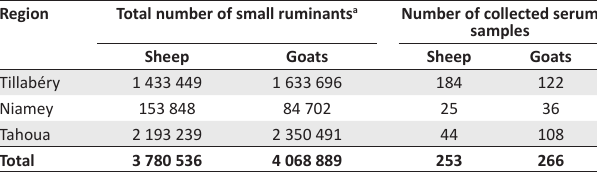
TABLE 2: Distribution of samples by region. Region Total number of small ruminants a